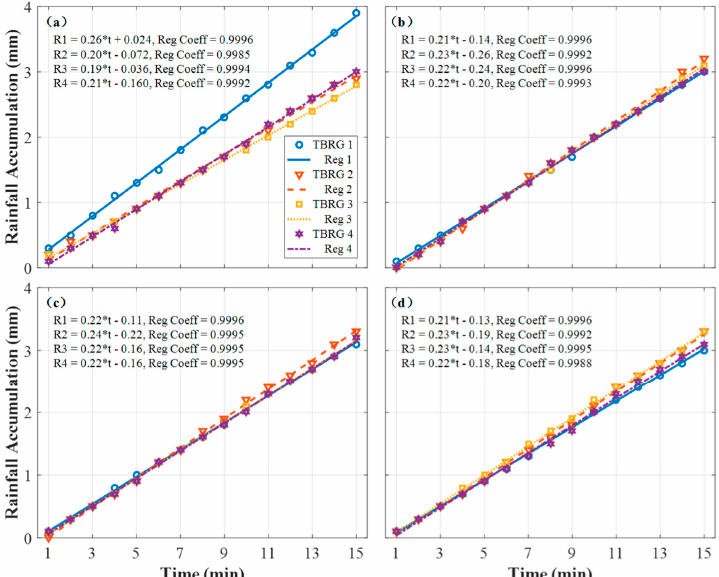
Figure 9. Rainfall accumulation consistency of four tipping-bucket rain gauges (TBRGs) at different rotary speed in 15 min. The four rotary speeds were ( a ) 0 RPM, ( b ) 1 RPM, ( c ) 2 RPM, and ( d ) 3 RPM. Rk refers to the rainfall accumulation regression curves of TBRG k and Reg Coeff refers to the regression coefficient of TBRG k (k = 1, 2, 3,